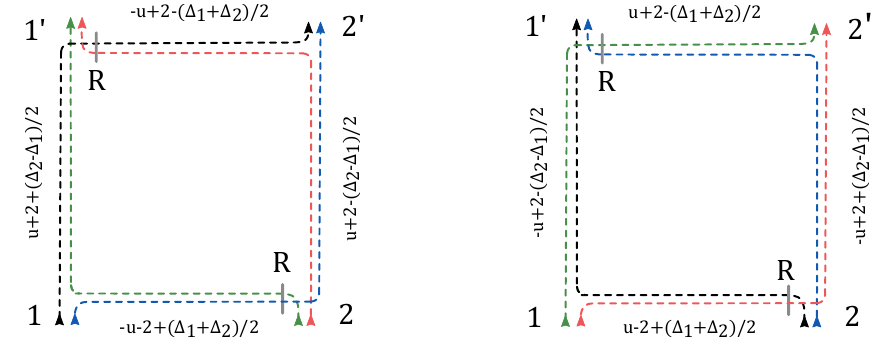
ˆ ) of the operator ˆ R ( u ) . The superscripts R 12 ( x 1 , x 2 | x 0 , x 0 12 1 2 ( u ) 12